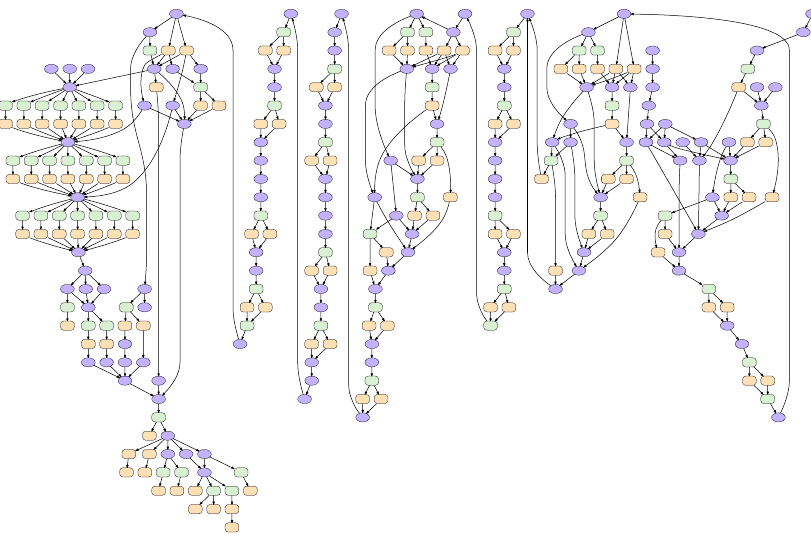
Figure 2. Illustration of the computational complexity of the COSMO dynamical core, using a CDAG. The nodes of the graph represent com- putational kernels (blue ellipses) that can have multiple input and output variables, halo updates (green rectangles), and boundary condition operations (orange rectangles). The edges of the graph represent data dependencies. Since the dynamical core of COSMO has been written using a DSL, the CDAG can be produced automatically using an analysis back end of the DSL compiler. The lengthy serial section in the middle of the figure corresponds to the sound waves sub-stepping in the fast-wave solver. The parallel section in the upper left corresponds to the advection of the seven tracer variables. CDAGs can automatically be produced from C++